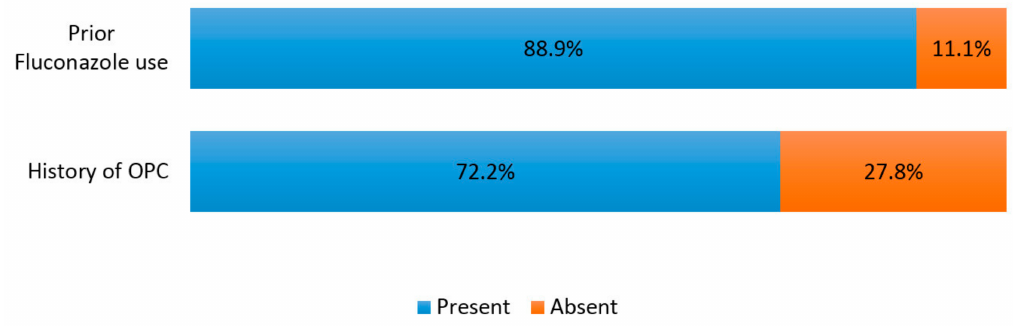
Figure 2. Prevalence of prior fluconazole use and history of OPC in fluconazole-resistant